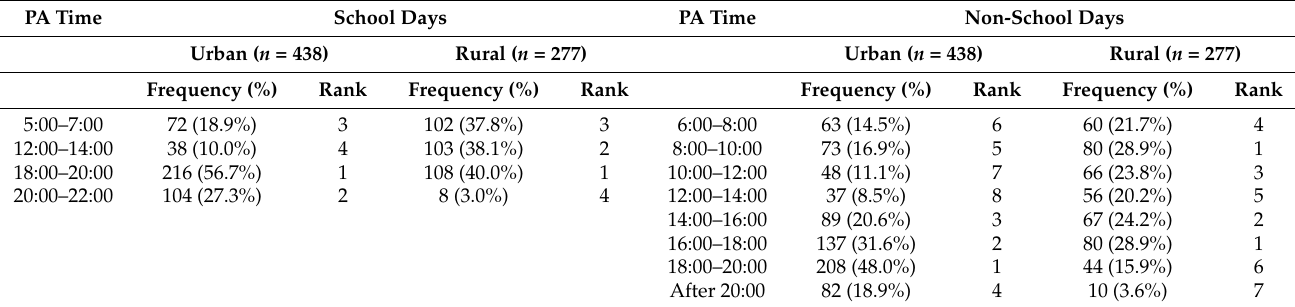
Table 5. PA Time When Students Played on School and Non-school